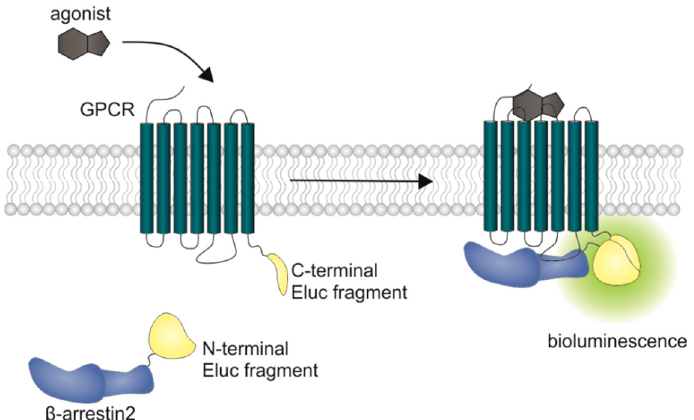
Figure 1. Schematic illustration of the split luciferase β -arrestin2 recruitment assay. Complementary fragments of the Emerald luciferase were fused to β -arrestin2 and the D 1 R, the D 2long R, the D 3 R or the D 4.4 R. Upon agonist stimulation of the receptor, β -arrestin2 is recruited and the luciferase fragments come into close proximity to form a functional enzyme, which catalyzes the oxidation of D-luciferin to oxyluciferin, accompanied by the emission of light ( λ max = 535 nm).